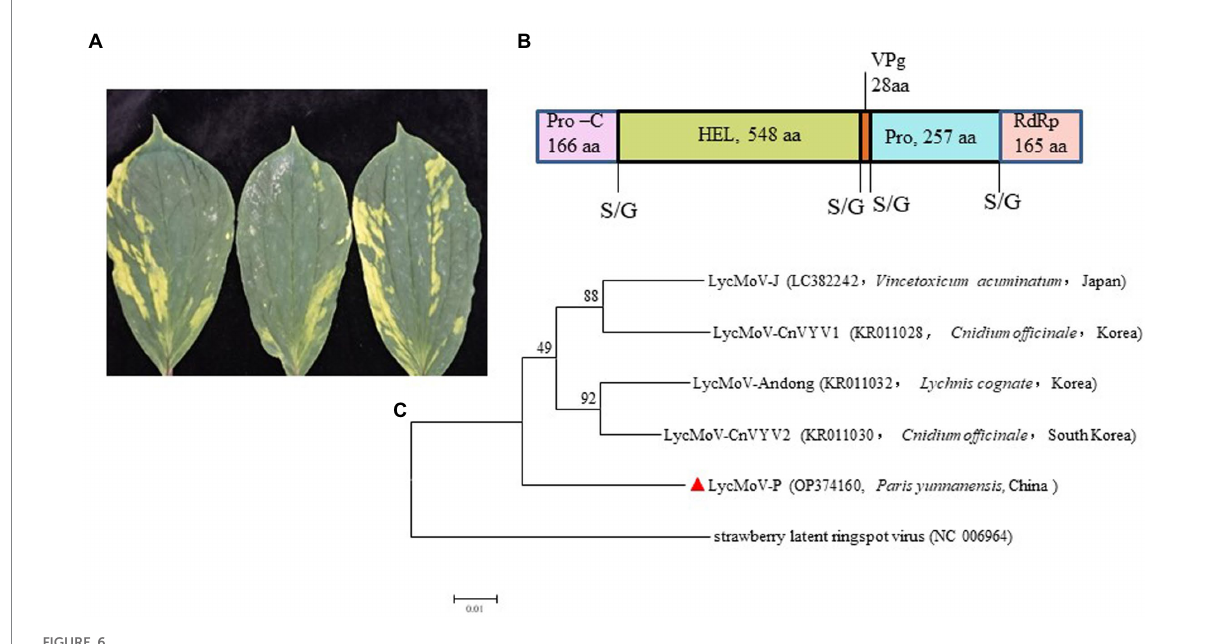
FIGURE. 6 Symptoms, the structure for partial genomic sequence of RNA1, and phylogenetic tree of Lychnis mottle virus P. yunnanensis isolate (LycMoV-P): (A) Symptoms induced by co-infection of ParPV-3 + PMNV+LycMoV, (B) partial genomic structure of LycMoV-P RNA1, (C) Maximum-likelihood tree based on the partial aa sequence of LycMoV-P RNA1 and those of other isolates, and strawberry latent ringspot virus, another species in the genus Stralarivirus . Bootstrap analysis was applied using 1,000 bootstrap replicates. The scale bar representing a genetic distance of 0.01. Solid triangle indicated the LycMoV-P.